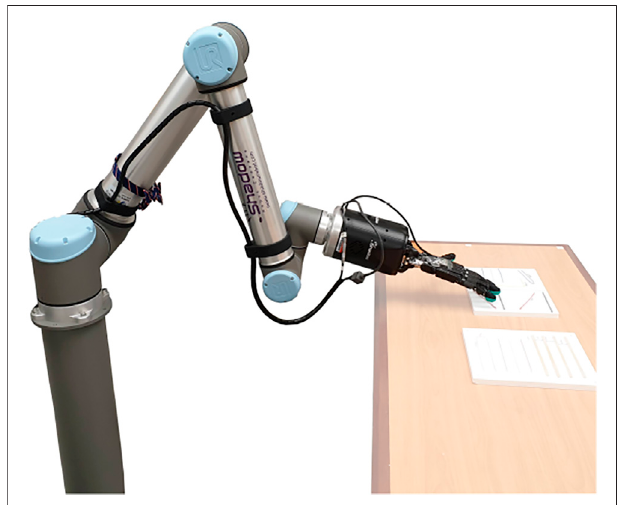
FIGURE 3 | Hardware Setup: Shadow Hand mounted on UR-10